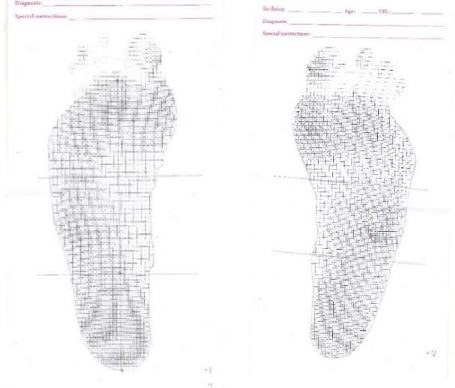
Figure 6. Typical example of ink-type footprint diagram.